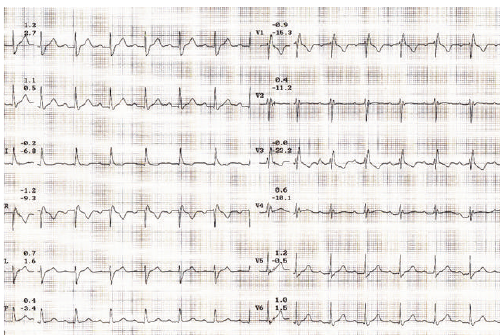
Figure 1: Baseline electrocardiogram showing sinus rhythm with right bundle branch block (RBBB).